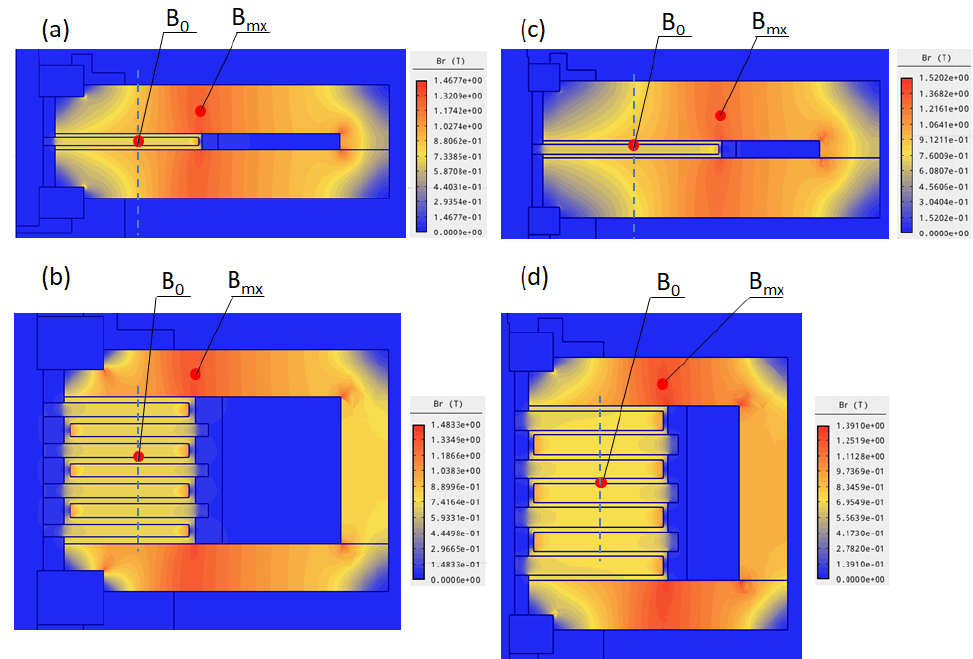
Figure 9. Magnetic field distribution for the selected variants: variant 1 ( a ), variant 2 ( b ), variant 3 ( c ), variant 4 ( d ).